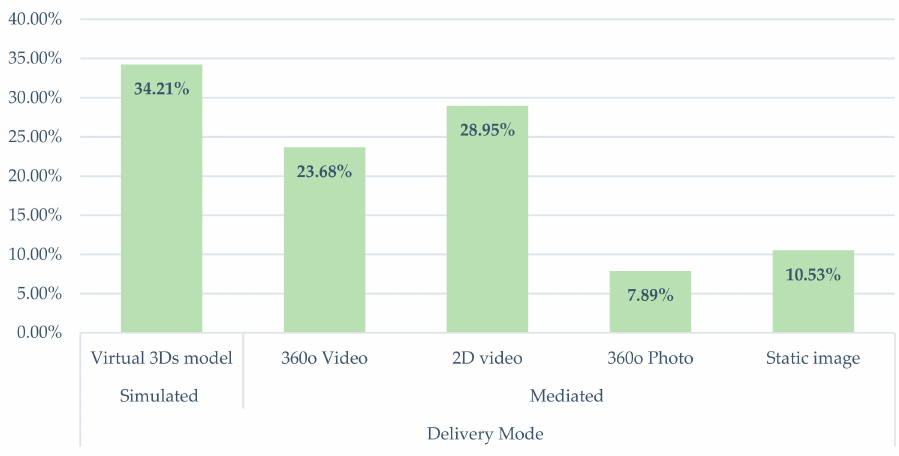
Figure 3. Distribution of the reviewed studies employing virtual natural environment based on delivery